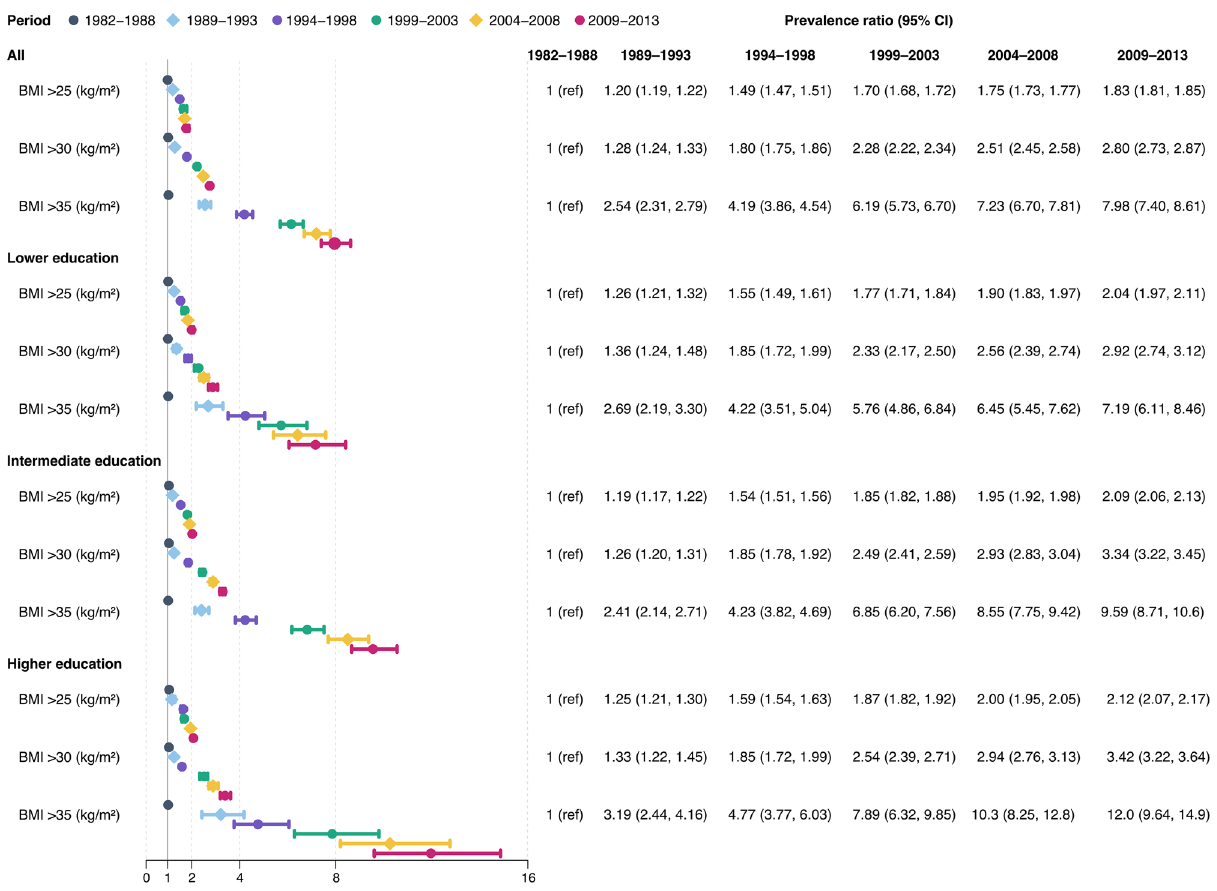
Figure 3. Age-adjusted prevalence ratios of overweight, moderate and severe obesity, by education and period. Age-adjusted prevalence ratios with corresponding confidence intervals for overweight, moderate and